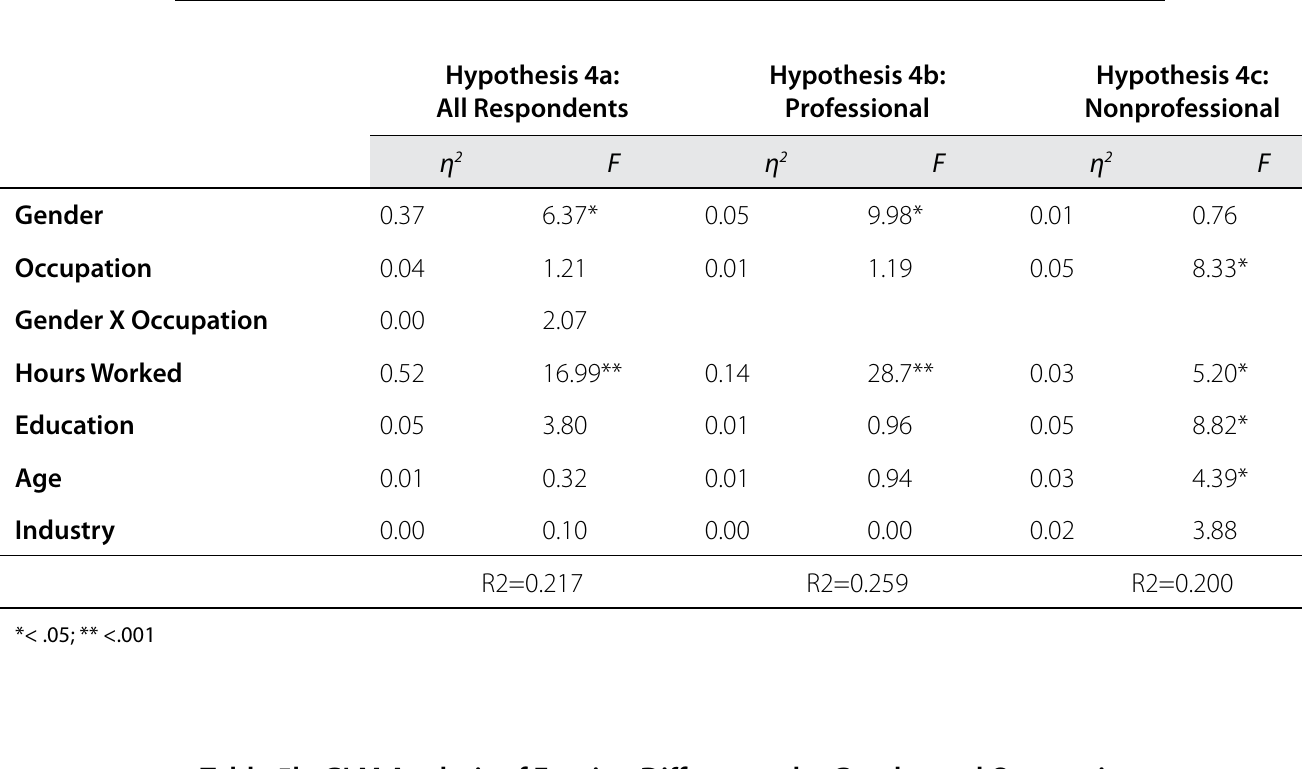
Table 5a. GLM Analysis of Earning Differences by Gender and Occupation